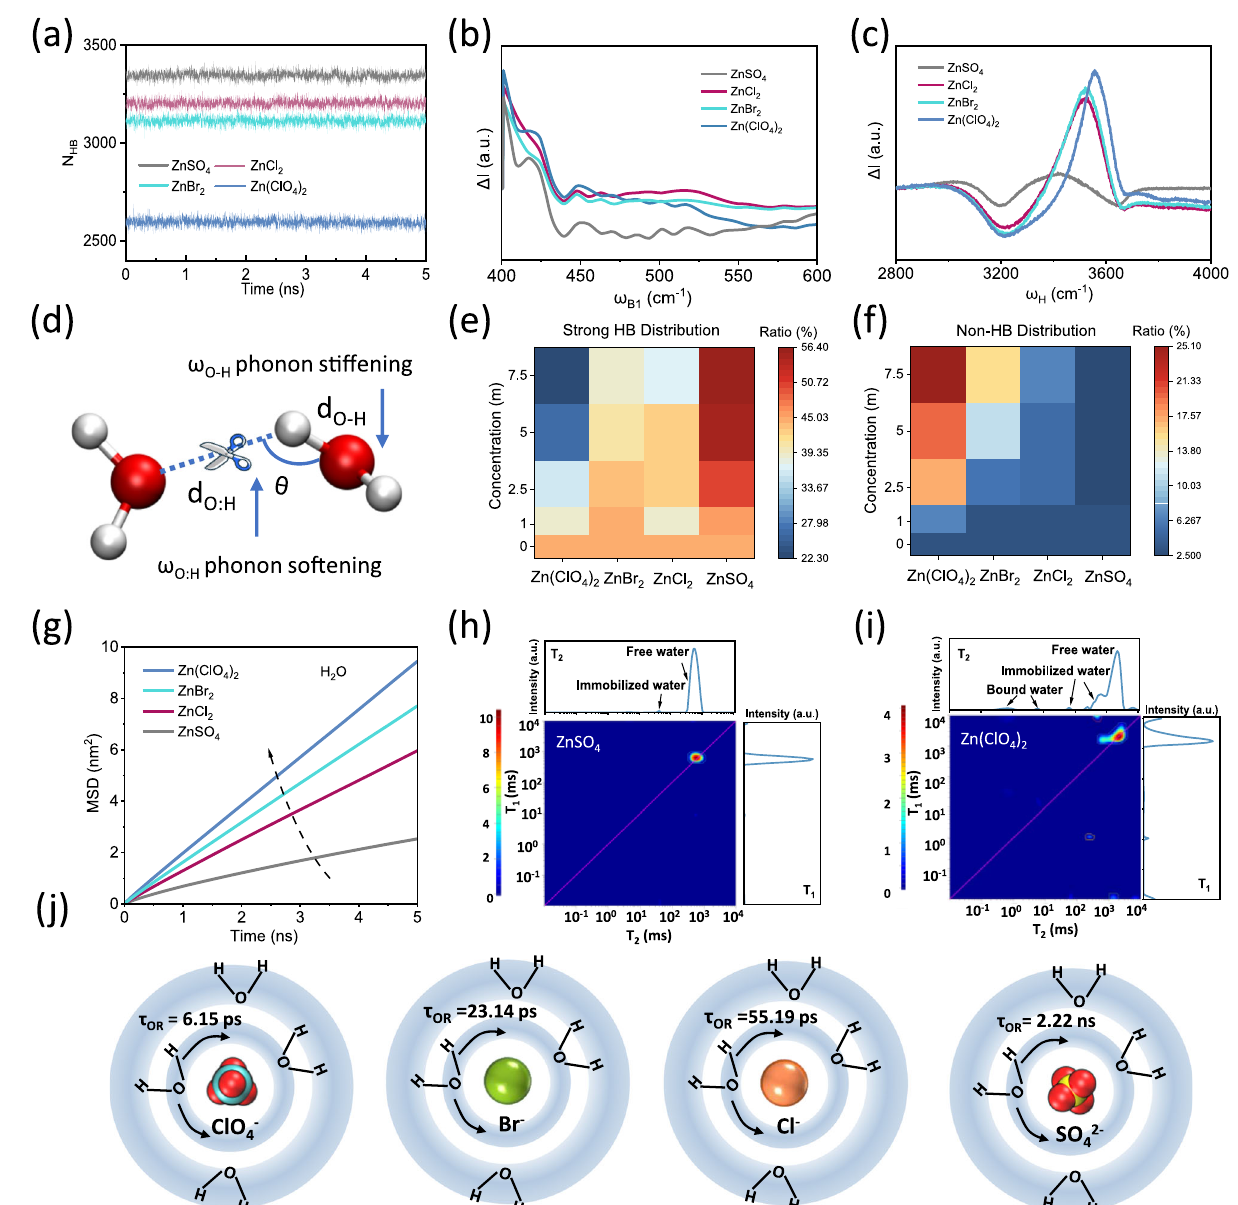
Fig.2|TheoreticalandexperimentalanalysisoftheHBstructureanddynamic relaxation behavior ofwater. a The average HBnumber of water clusters in four 5m ZnX (X=ClO 4 - , Br - , Cl - and SO 4 2- ) electrolytes collected from MD simulations. Comparison of the DPS of the four electrolytes with respect to the reference spectrum of pure water, which derived from ( b ) FTIR and ( c ) Raman spectra. d Schematic showing HB breakage for two water molecules, leading to an elon- gation of the O:H non-bond and shortening of the O-H polar bond, representing a